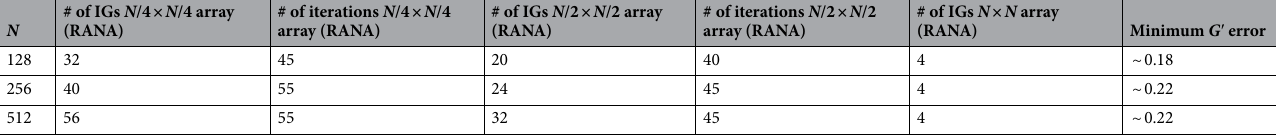
Table 1. Parameters used for trains with trace sizes 128 × 128, 256 × 256, and 512 × 512 (IG: initial guess).